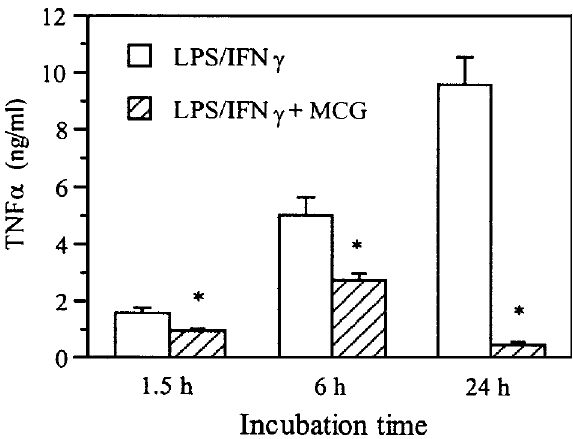
FIG. 4. Time course of the effect of MCG on macrophage secreted TNF a levels. Adherent macrophages (200,000) were cultured with LPS + IFN g in the presence or absence of MCG (100000 mast cell equivalent). After the indicated times, media were collected and TNF a levels were measured by ELISA. Each value presented is the mean ± SEM of quadruplicate determinations. This is representative of two experi- ments.* P <0.05 vs. LPS+IFN g only at the same time point.